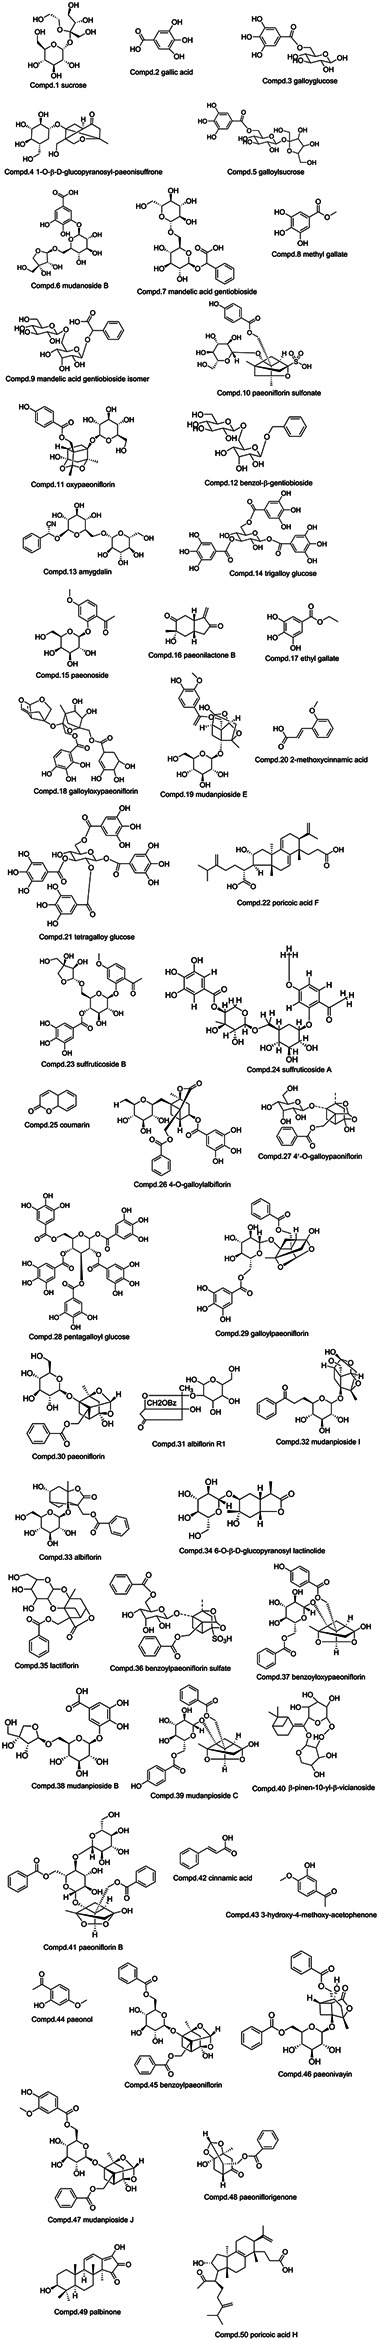
Chemical structures identified in GFP.